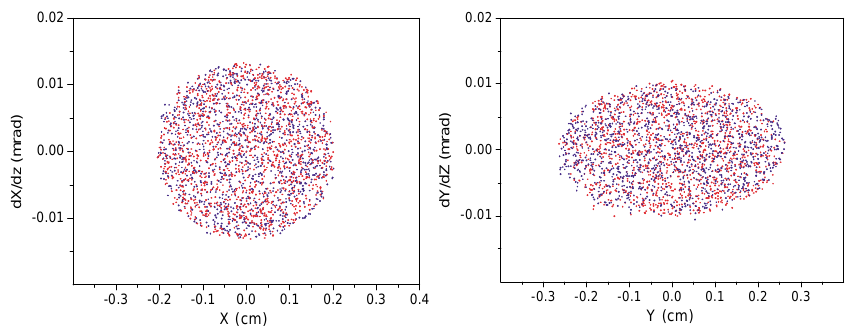
FIG. 10. (Color) Transverse phase space plots of 238 U 1 28 (red dots) and 238 U 1 29 (blue dots) beams exiting the RFQ.